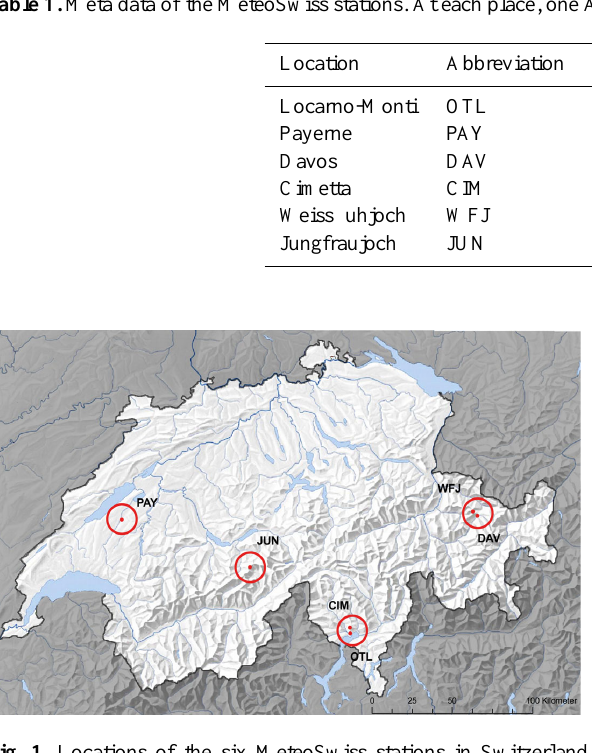
Fig. 1. Locations of the six MeteoSwiss stations in Switzerland (geodata © swisstopo). The coordinates of the locations are from MeteoSwiss